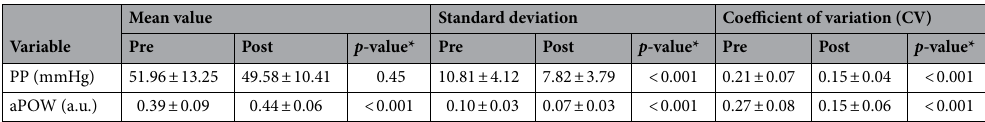
Table 2. Pre- and post-ECV values of PP and aPOW signals in the 44 patients included in the signal post- processing phase. * p values are derived by Kolmogorov–Smirnov test.